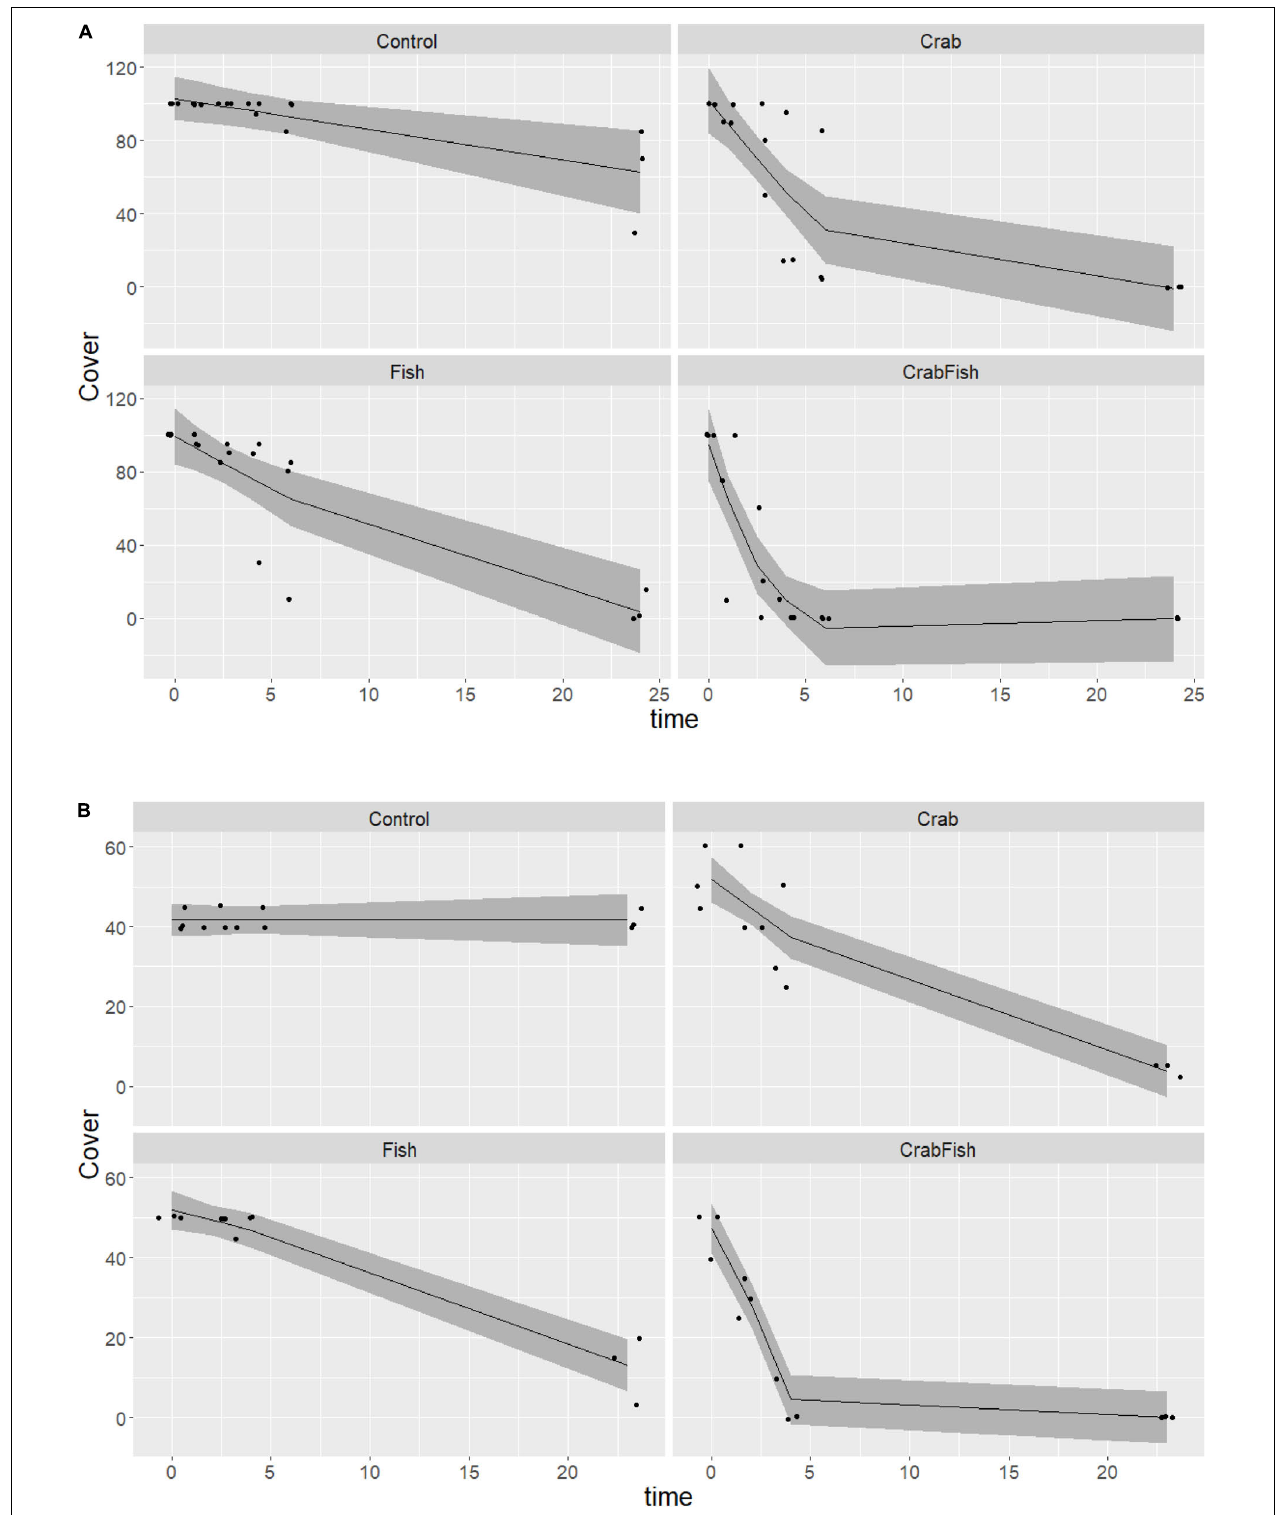
FIGURE 2 | Predicted and observed development in M. edulis cover over time in a 24 h experiment in August (A) and in October (B) 2019, given four different treatments (Control: no predators added, Crab: only crabs added as predator, Fish: only fish added as predator, CrabFish: i.e., both crabs and fish added as predator species to the mesocosms). The shaded area shows the 95% confidence levels of the predicted GAM values (i.e., cover as a function of treatment + time × treatment) and the points represent the observed cover at different times. There were always three replicates, and some overlapping points are not visible.